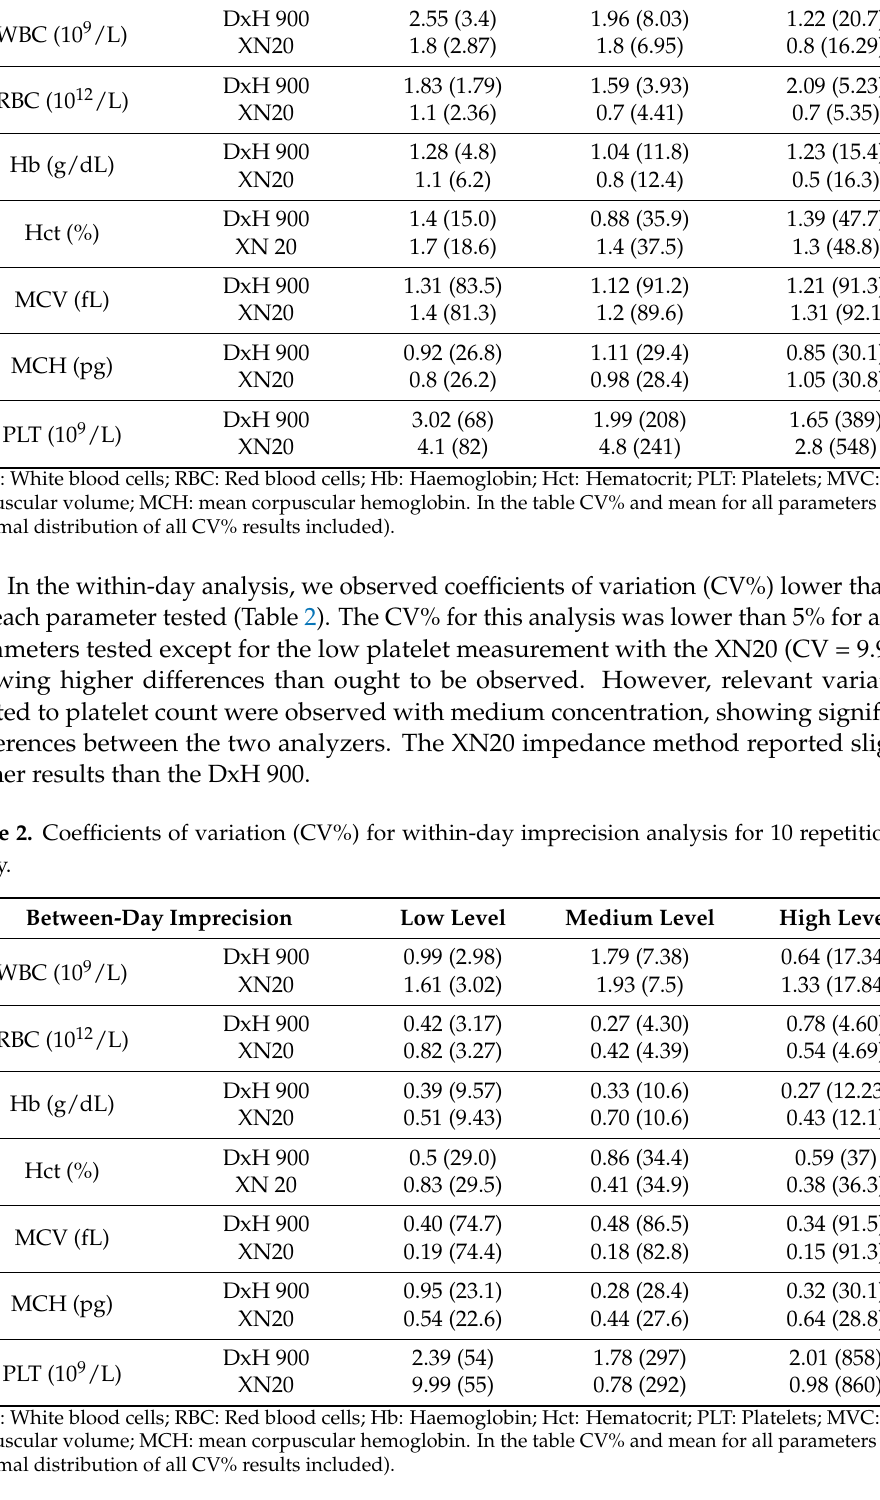
Table 1. Coefficients of variation (CV%) for between-day imprecision analysis during 25 days. Within-Run Imprecision